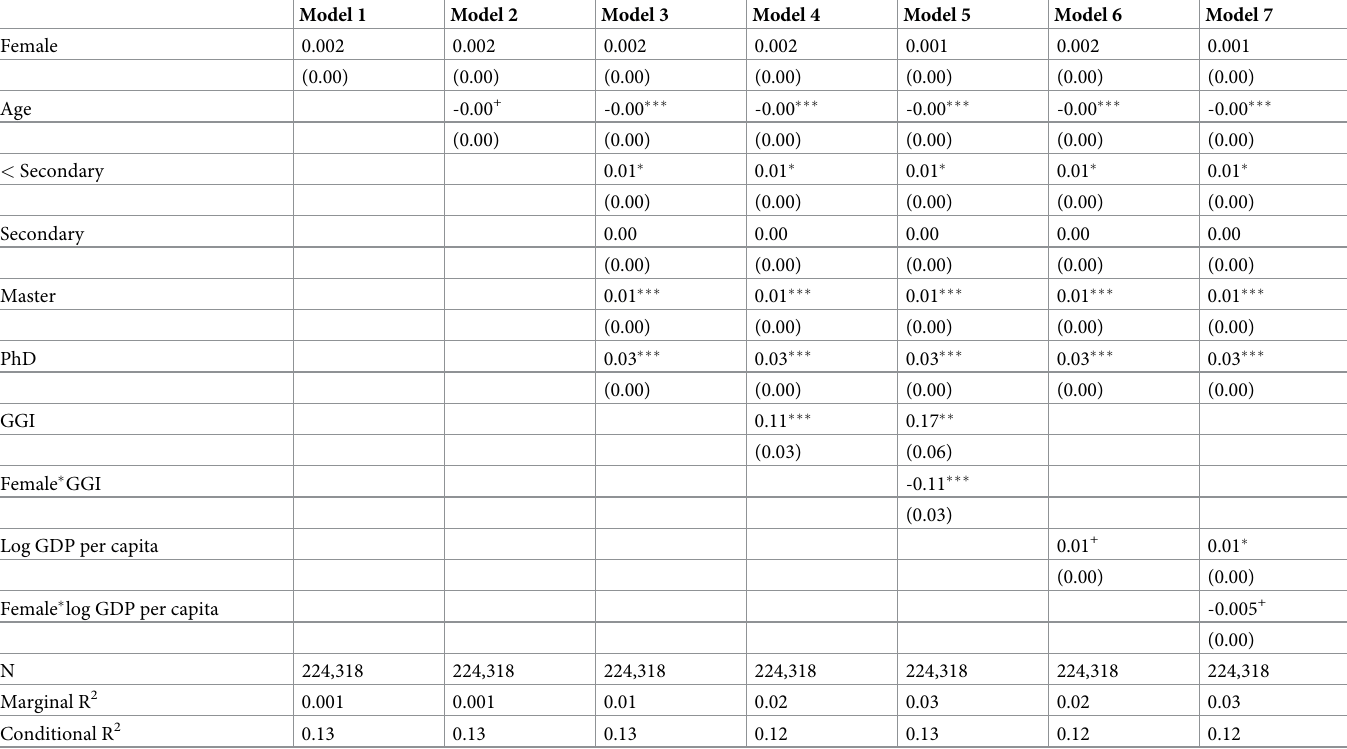
Table 3. Multilevel logistic regression for completing conditional on STEM MOOC